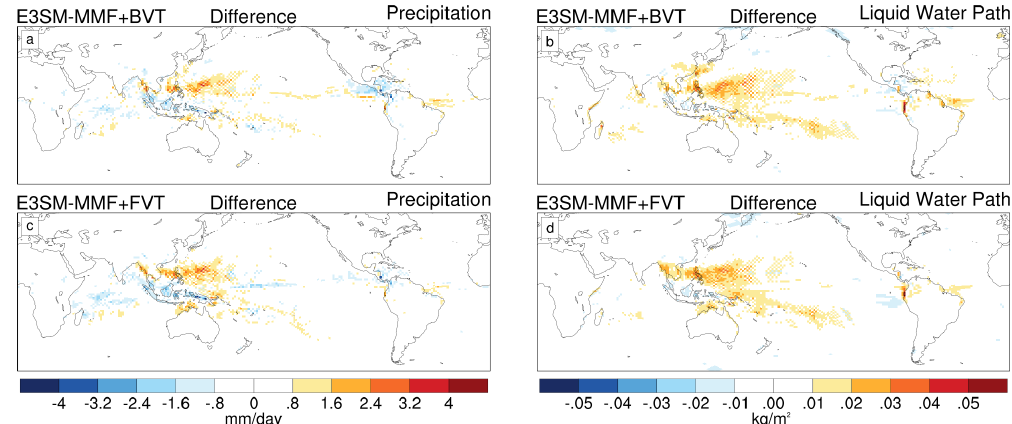
Figure 2. Maps of 10-year mean precipitation and liquid water path differences relative to the E3SM-MMF control simulations for E3SM-